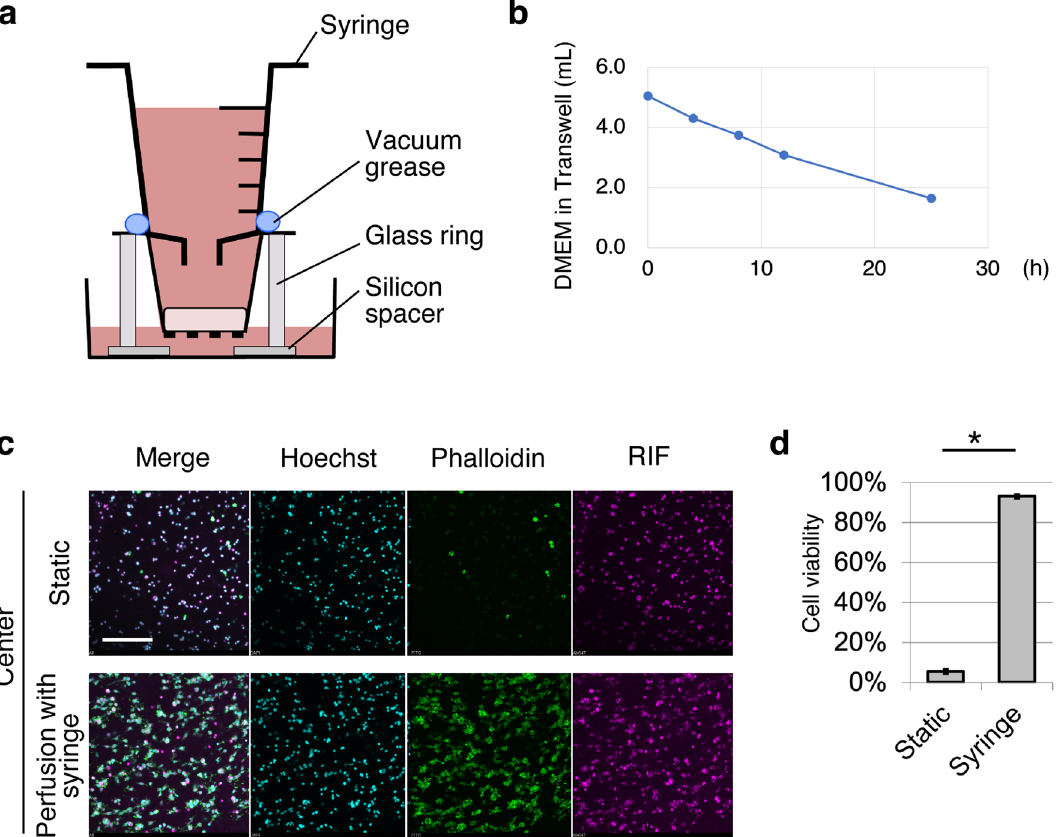
Figure 3. Cell viability improved with PCC-WLD with a syringe. ( a ) Schematic of PCC-WLD with a syringe. ( b ) Flow rate of DMEM from the Transwell in PCC-WLD with a syringe. n = 3 independent experiments. ( c,d ) Fluorescent images ( c ) and analysis ( d ) of the live/dead cell assay. Cells were cultured for 3 days. n = 9 fields from 3 independent experiments. Cyan, Hoechst. Green, phalloidin. Magenta, RIF. Scale bar, 200 μm. Mean ± S.E., *p < 0.0001 by Student’s t